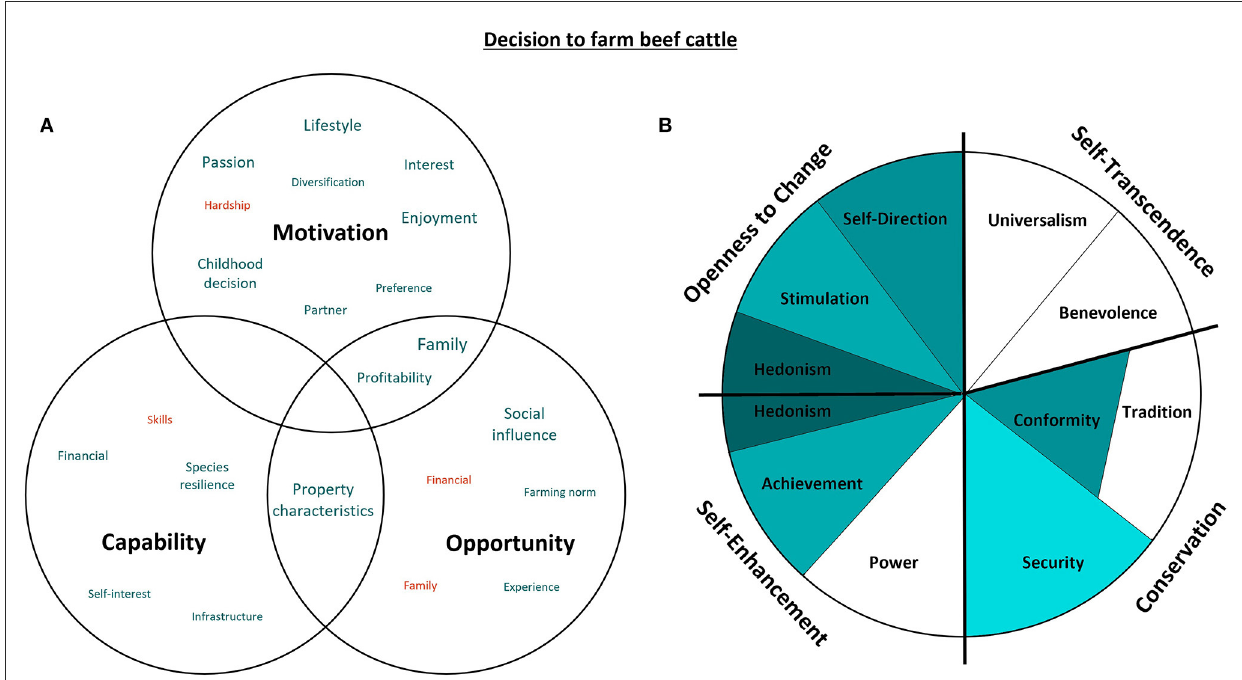
FIGURE4 Capability, opportunity, motivations and values associated with the decision to farm beef cattle. Green represents attributes that support the decision to farm beef cattle, while red indicates confounding attributes. The size of the text in the Venn diagram (A) indicates the commonality of themes amongst the participants, as does darker shading in the value wheel (B) [adapted from Schwartz (29). CC BY-SA